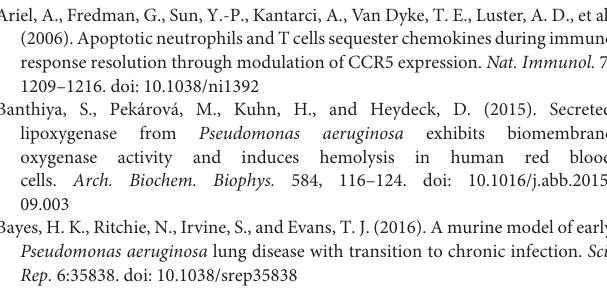
TABLE S5 | Strains and plasmids used in this study. TABLE S6 | Primers used in this study. TABLE S7 | Scoring and ranking of LoxA